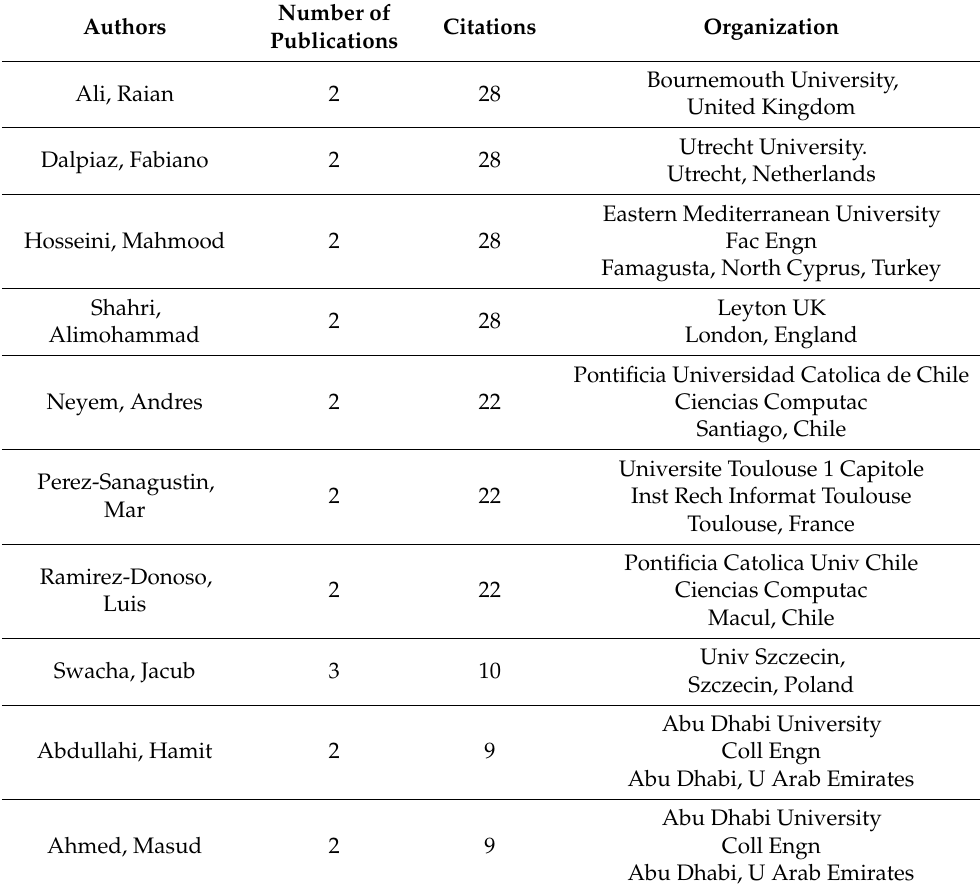
Table 5. Top 10 most prolific authors, ordered by the number of